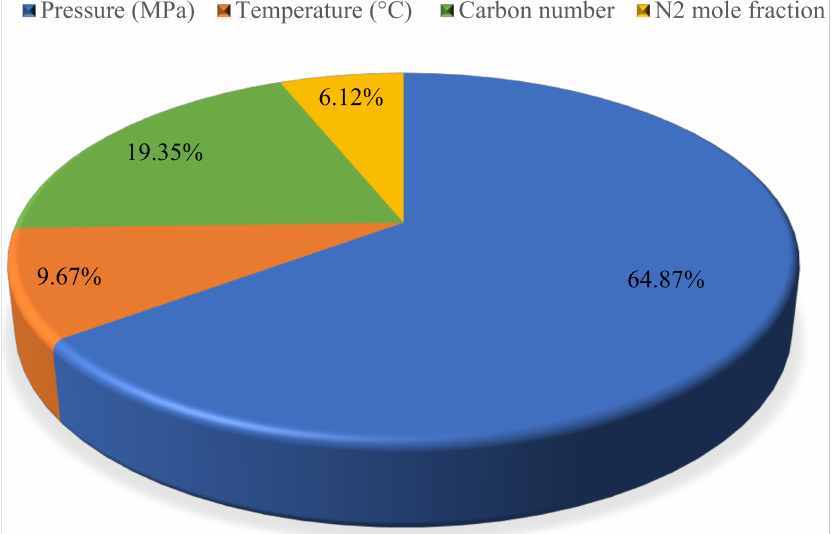
Figure 11. Importance assessment of input parameters on IFT of N 2 /CO 2 mixture +